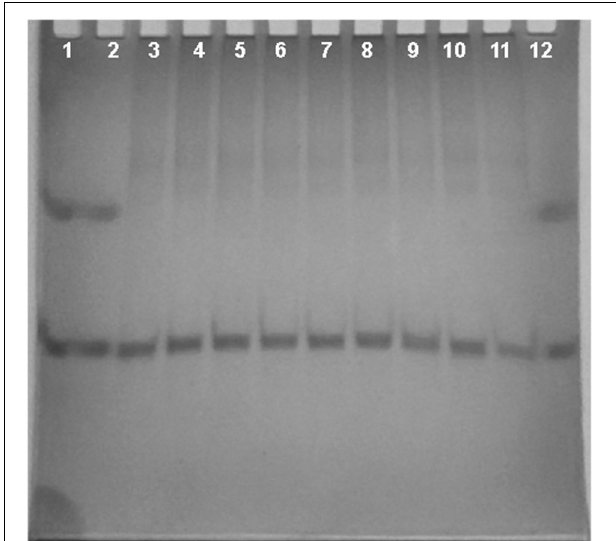
FIGURE 4 | Nondenaturing PAGE. Nondenaturing PAGE of human telomeric DNA tel23-p (50 μ M) with increasing equivalents of ligands (2 and 4 eq.) at 5 ◦ C. Lanes 1 and 2: bromophenol blue; lane 3: tel23-p alone; lane 4: [ tel23-p + 1a ] 1:2 mixture; lane 5: [ tel23-p + 1a ] 1:4 mixture; lane 6: [ tel23-p + 1b ] 1:2 mixture; lane 7: [ tel23-p + 1b ] 1:4 mixture; lane 8: [ tel23-p + 2a ] 1:2 mixture; lane 9: [ tel23-p + 2a ] 1:4 mixture; lane 10: FIGURE 5 | Analysis of DNA damage response by bis-indole derivatives